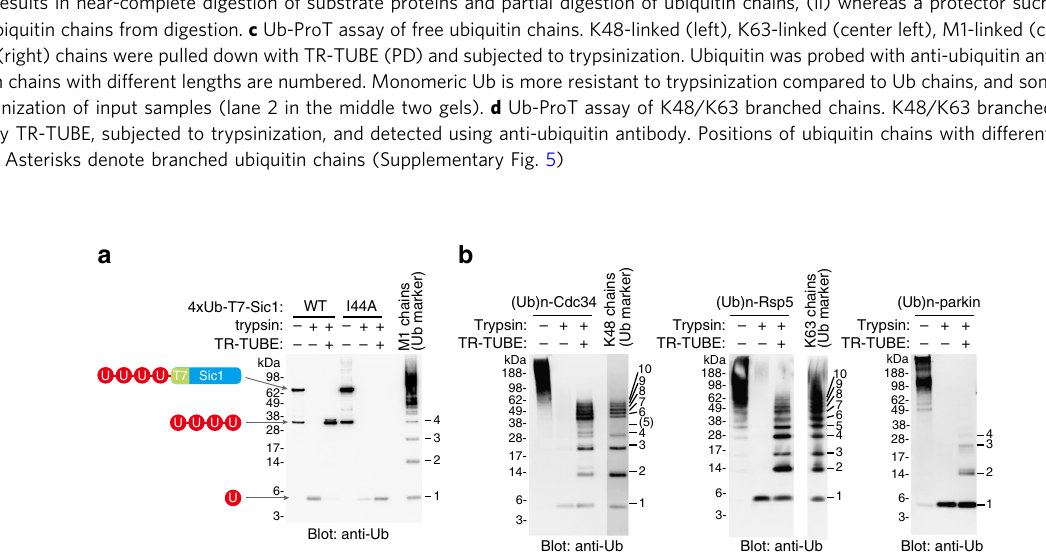
Fig. 2 Ub-ProT protects substrate-attached ubiquitin chains in vitro. a Ub-ProT assay of tetraubiquitin-fused Sic1. M1-linked tetraubiquitin-fused T7-Sic1, cleaved tetraubiquitin, and ubiquitin monomer are indicated. A ubiquitin mutant (I44A in each ubiquitin moiety, resulting in a defect in TR-TUBE binding) was used as a control. Unanchored M1 chains were used as ubiquitin markers. b Ub-ProT assay of ubiquitylated proteins. Self-ubiquitylated GST-Cdc34 (Ubn-Cdc34, left), self-ubiquitylated GST-Rsp5 (Ubn-Rsp5, middle), and self-ubiquitylated MBP-Parkin (Ub-Parkin, right) were subjected to Ub-ProT. Free ubiquitin chains were used as markers